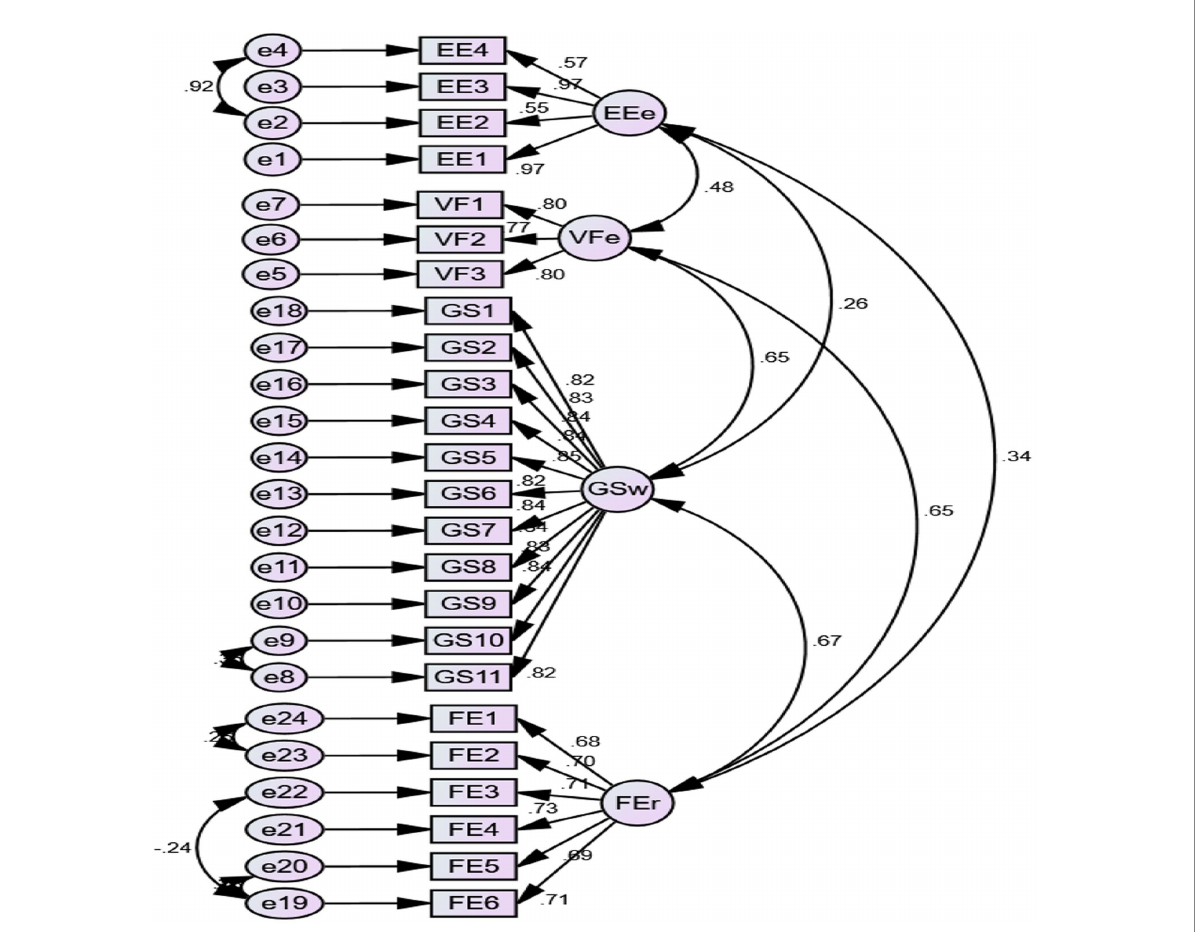
FIGURE 2 Model Fit. EE, entrepreneurial education; VF Intention toward venture capital; GS, government support; FE, financial